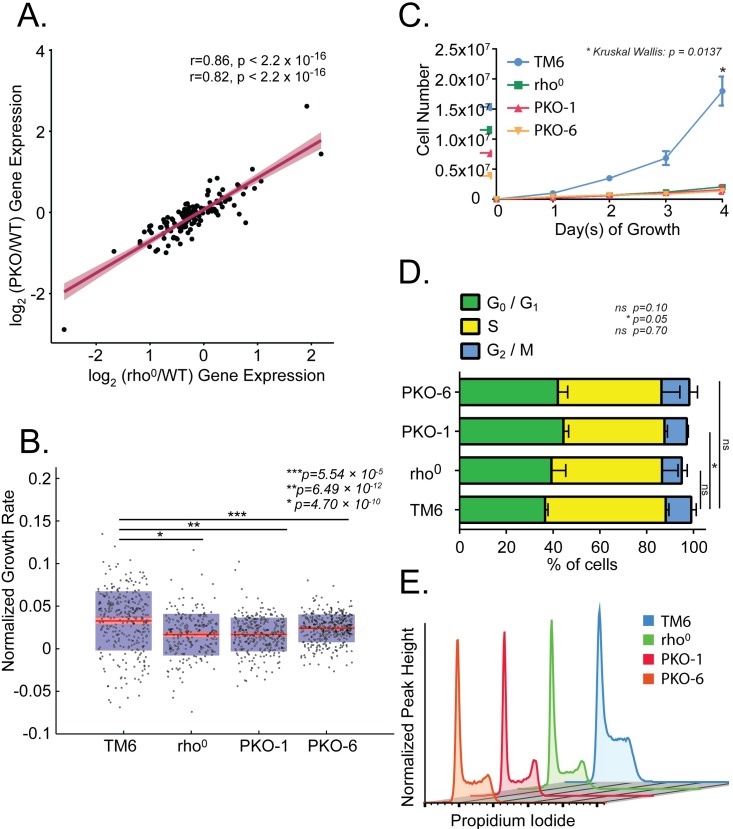
PKO and rho0 MEFs have similar cell growth, cell cycle and metabolic gene expression profiles.(A) Scatterplot of mitotic gene expression changes between PKO (y-axis) and rho0 (x-axis) MEFs with respect to TM6 MEFs (calculated as log2 fold-change) (n = 3 biological replicates per line, 12 total). Linear regression lines were fit and Pearson (top value) and Spearman (bottom value) correlation coefficients were calculated with accompanying P values calculated using two-tailed t significance tests. Gene sets were derived from KEGG database cell cycle ID MMU04110. (B) Growth (biomass accumulation) rates for TM6, rho0, PKO-1, and PKO-6 cells were quantified by live cell interferometry (TM6 n = 308, rho0: n = 233, PKO-1: n = 303 PKO-6: n = 364). (Median = red stripe, 95% confidence interval = pink region ± SD = purple region. (C) Proliferation of TM6, rho0, PKO-1 and PKO-6 MEFs by manual cell counting (n = 3, ± SD). (D) Stacked barplots of phases of the cell cycle in percentage distributions for TM6, rho0, PKO-1, and PKO-6 MEFs (n = 3, ± SD). (E) Representative flow cytometry profiles for TM6, rho0, PKO-1, and PKO-6 MEFs. DNA was stained with propidium iodide.